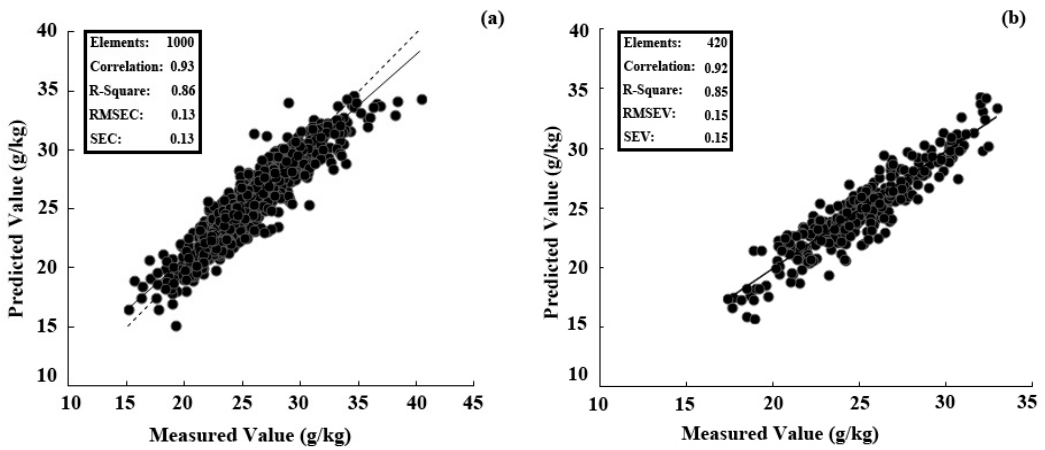
Figure 9. Measured vs. predicted N concentration for calibration ( a ) and validation ( b ) by the best partial least squares (PLS) regression model (factor = 15) with spectra measured using the black background. The solid line of ( a ) represented the best regression line and the dashed line of ( a ) represented the target line (1:1 line). The best regression line (solid line) and the target line (dashed line) in the validation set almost showed superposition.